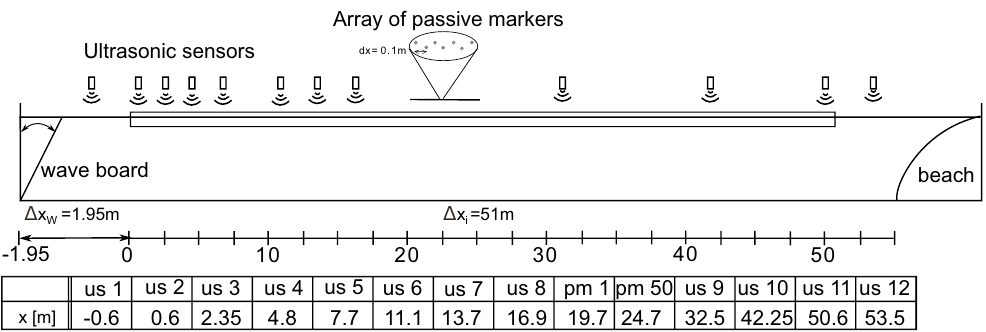
Figure 3. Schematic sketch of the experimental test setup and positions of the